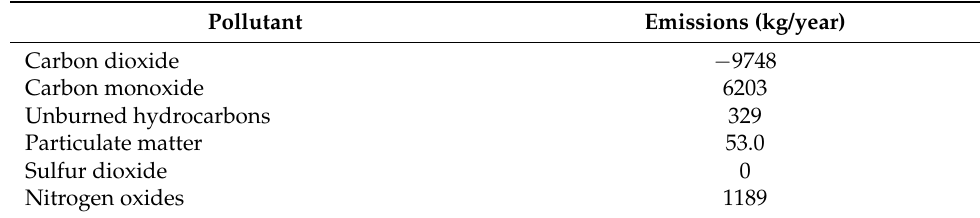
Figure 22. Annual PV generator operation.